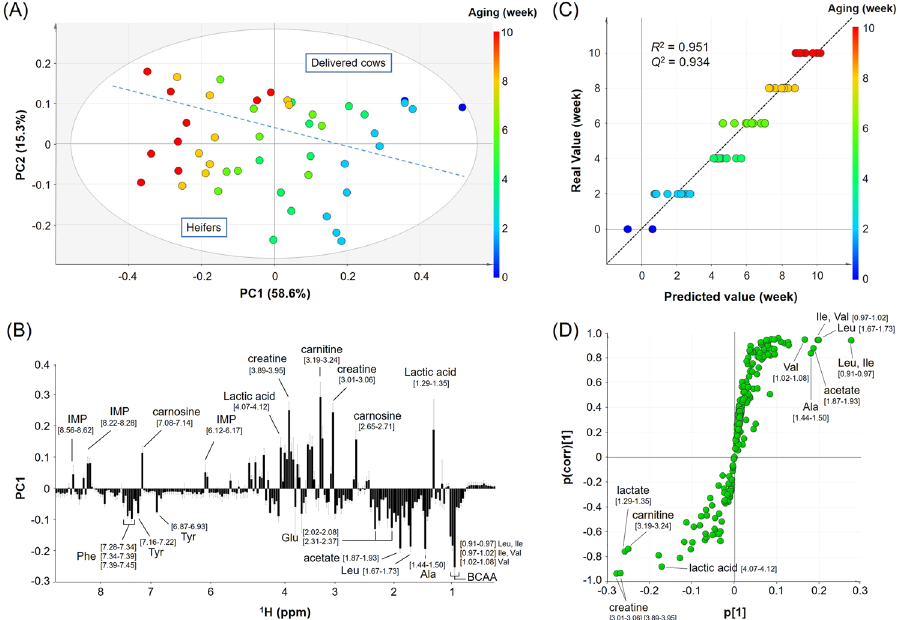
Figure 4. Multivariate data analysis of the 1 H NMR spectra of the D 2 O extracts of ribeye samples with different aging duration. Ribeye samples are derived from heifers and delivered cows. ( A ) PCA score plot of PC1 versus PC2. The plots are color-coded according to aging duration (week): 0, blue; 2, cyan; 4, turquoise; 6, light green; 8, yellow; and 10, red. The heifer samples are positioned separately from the delivered cow on the score plot, and the individual regions are divided by a dashed line. ( B ) Loading plot for PC1 of the score plot shown in panel A. Buckets with high loading values are labeled by the assigned compound names. The square brackets represent the chemical shift range of each spectral bucket. ( C ) OPLS regression model for the prediction of aging duration. Predicted values are derived from the OPLS model of the 1 H NMR spectra. The plots are color- coded according to aging duration (week): 0, blue; 2, cyan; 4, turquoise; 6, light green; 8, yellow; and 10, red. ( D ) S plot for the OPLS regression model shown in panel C. Buckets with high absolute values of p[1] and p(corr)[1] are labeled with the assigned compound names. The square brackets represent the chemical shift range of each spectral